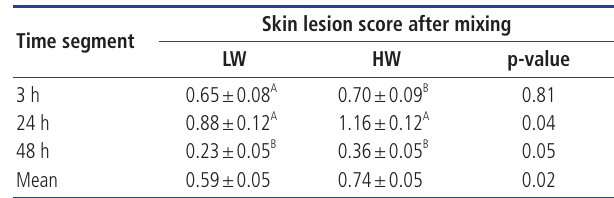
Table 2. Effects of 20-day litter weight and time on skin lesion score after